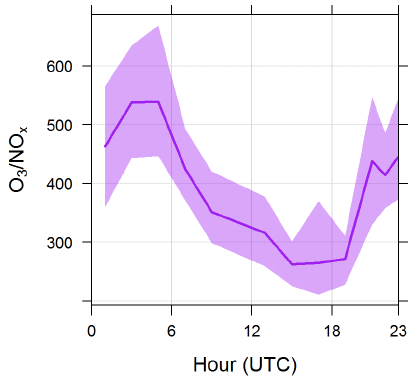
Figure 3. Averaged diel variation of CH 3 Cl ( A ), CO ( B ), SO 2 ( C ) and NO 2 ( D ) during summer 2017. The shaded area denotes the 95% confidence level.